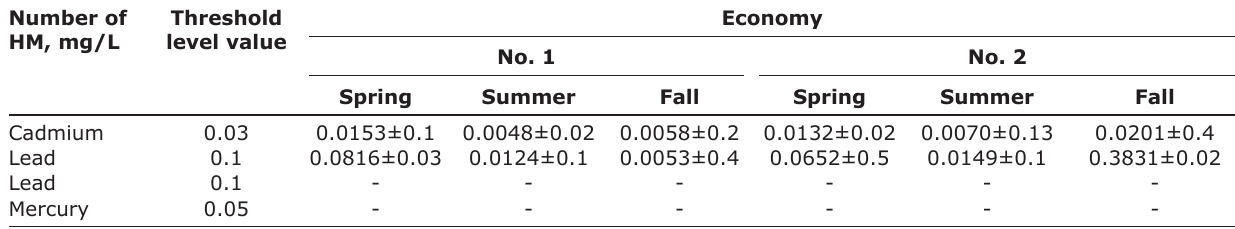
Table-3: Content levels of HM in samples of mare’s milk (saumal) of the studied farms, M±m. Number of HM, mg/L